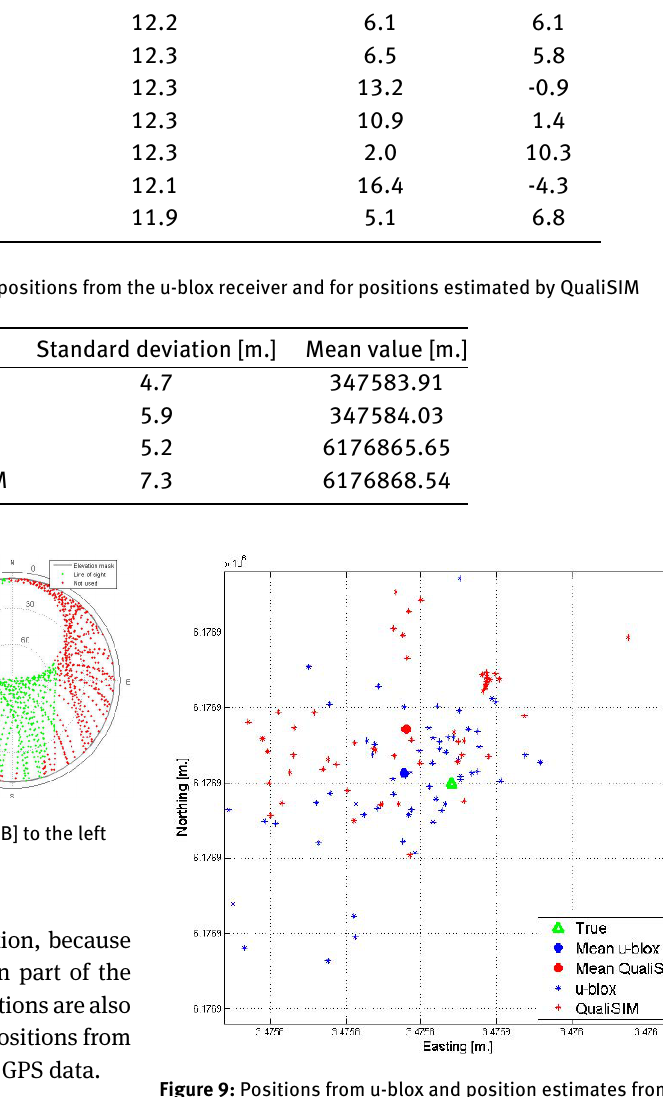
Figure 9: Positions from u-blox and position estimates from Qual- iSIM in cityscape environment. The grid spacing is 5